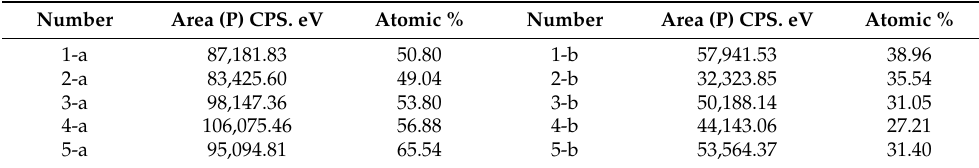
Table 3. Surface analysis results of the C element.